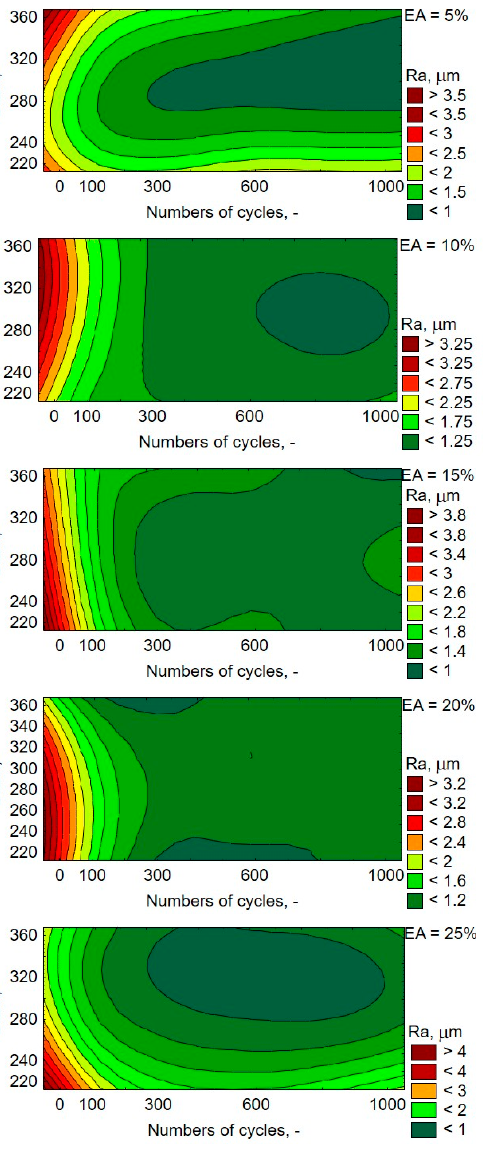
Figure 4. Characteristics of changes in parameters Ra and Rmax, depending on the number of friction cycles and grain of alundum.